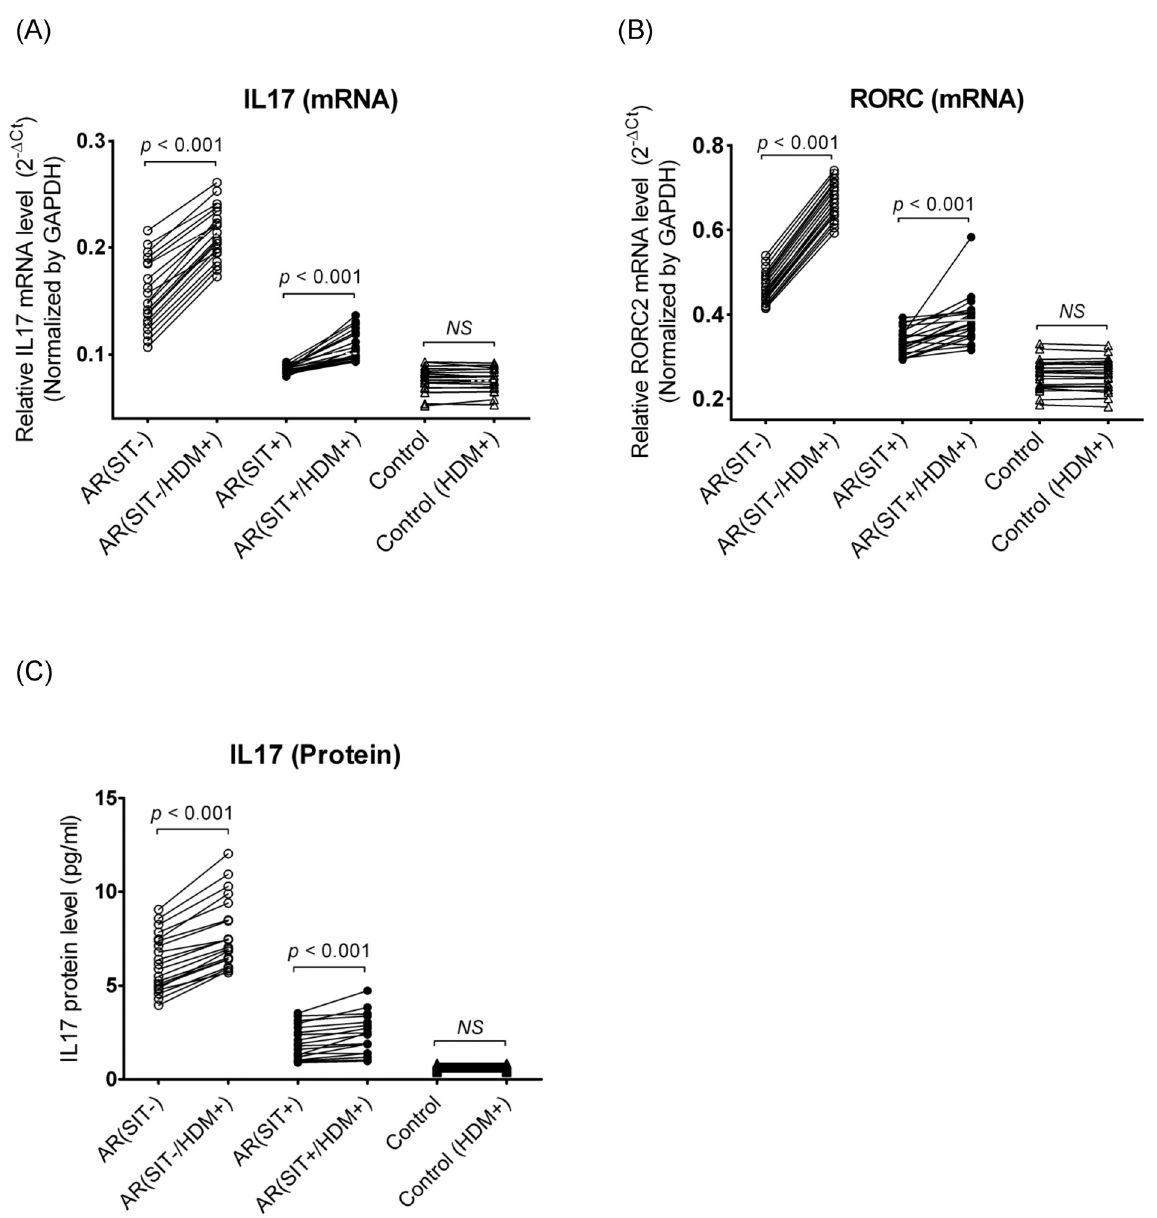
Figure 4. Quantitative determination of mRNA by real-time RT PCR for IL17 (A) and RORC (B) in PBMCs and evaluation of protein production by ELISA for IL17 (C) in supernatant after HDM challenge. The samples were collected from SIT-untreated AR patients (open circles), SIT-treated AR patients (close circles) and the controls (open triangles). Connecting lines indicate data obtained in the same subject before and after HDM stimulation. Statistical analyses were performed by Wilcoxon matched pairs sign rank test. ‘‘ NS ’’ indicates not significantly different.